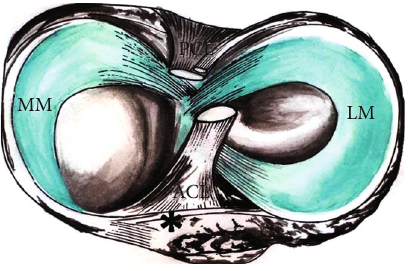
Figure 1: Meniscus schematic diagram [24].